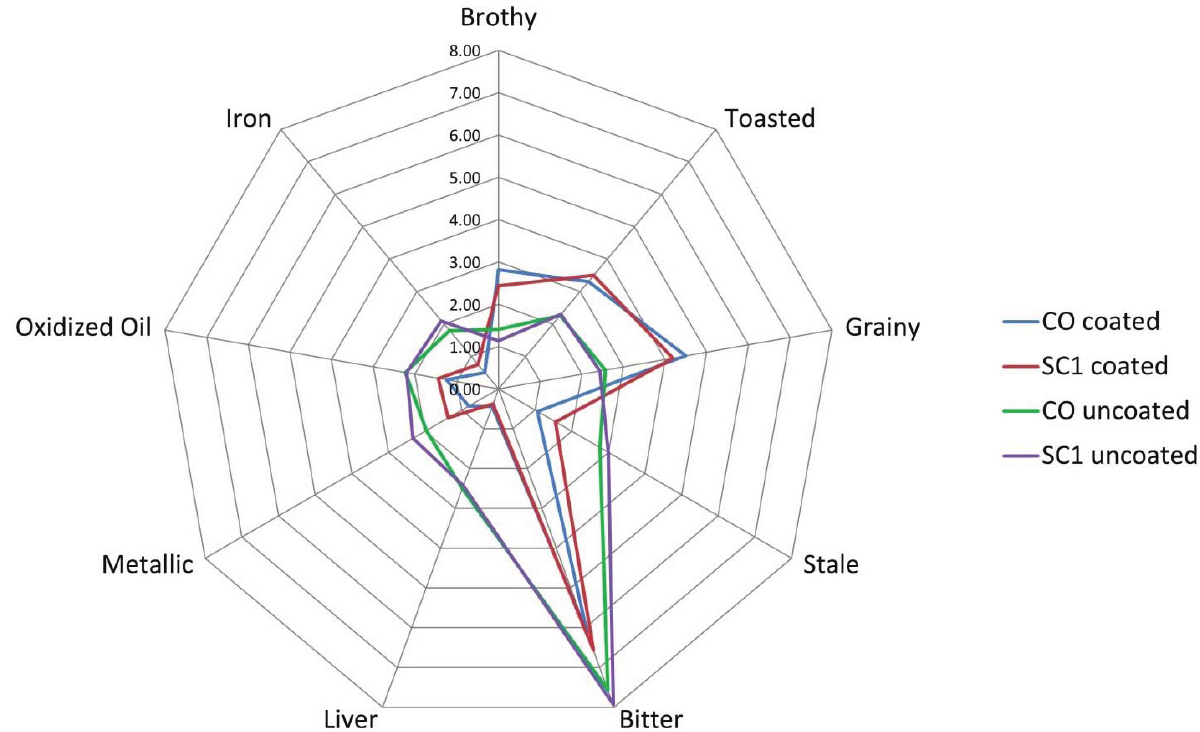
Figure 2. Poultry fat and palatant effect on kibble flavor. Only the Control (CO) sample and Sugar Cane large particles (SC1) samples are